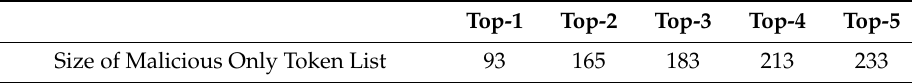
Table 4. Size of malicious only token Figure 11. False Positive Rate.